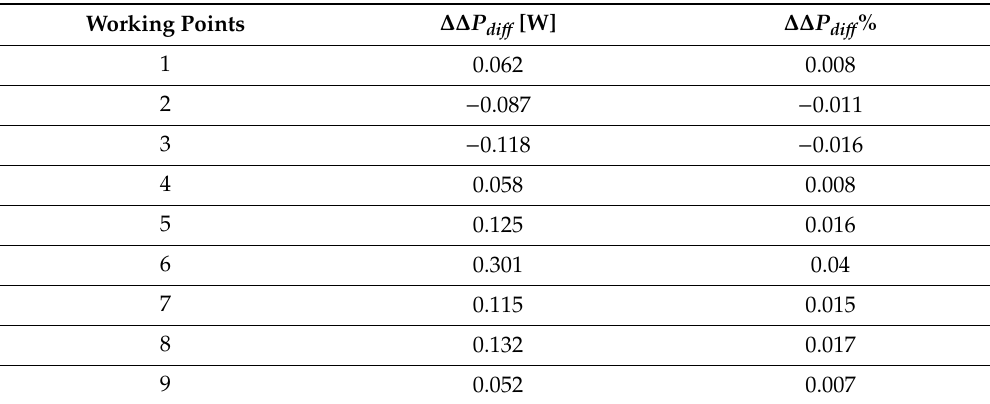
Table 12. Numerical results of the di ff erences between the ∆∆ P PDS and ∆∆ P PDS %. Working Points